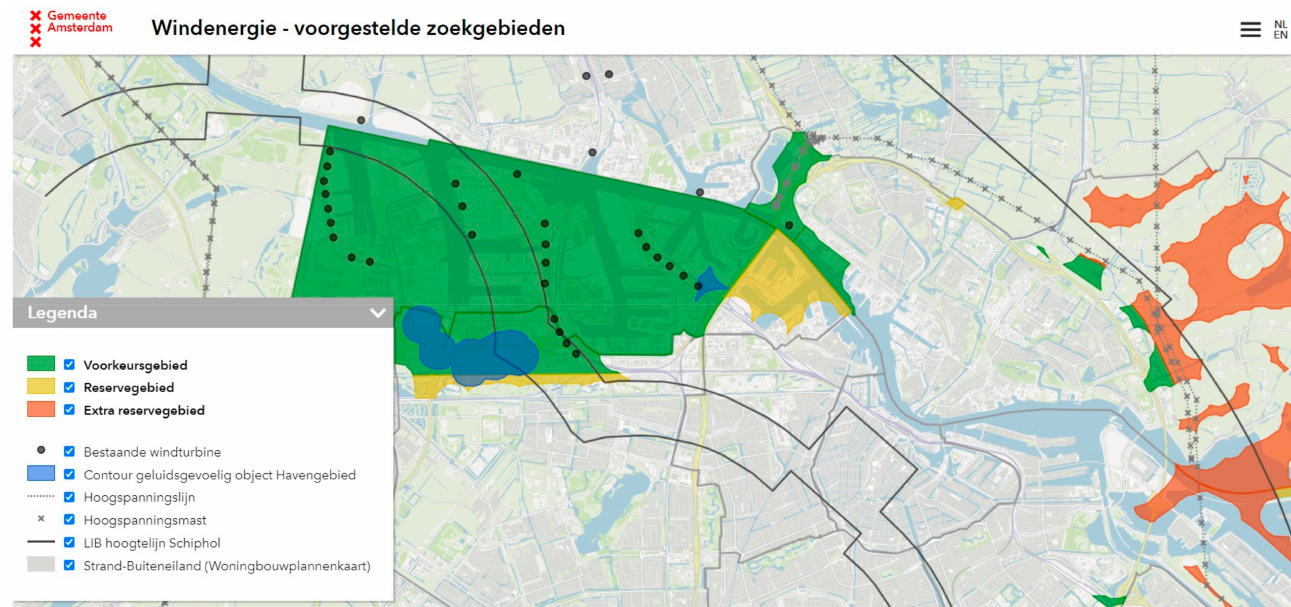
Figure 11. Wind energy of Amsterdam. Source: own study based on